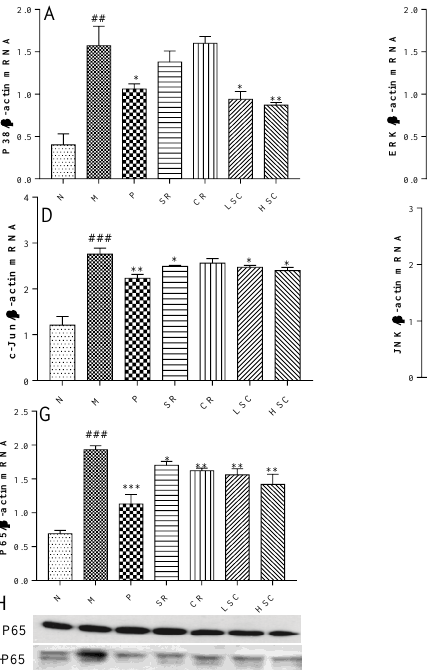
Figure 4. The effect of metformin (P), scutellaria Radix (SR), coptidis Rhizome (CR), low dose of combined extracts group (LSC) and high dose of combined extracts (HSC) on MAPK signaling pathway. ( A – G ) mRNA expression levels of c-jun N-terminal kinase (JNK), p38 mitogen-activated protein kinases (P38), extracellular regulated protein kinases (ERK), c-fos, c-jun, Inhibitor of nuclear factor kappa-B kinase (IKK) and P65 in liver of the N, M, P, SR, CR, LSC, and HSC by qPCR; ( H ) Protein levels of P65, phosphorylated P65 (p-P65) in liver of the N, M, P, SR, CR, LSC, and HSC by Western blot. The values are shown as mean ± SD. # p < 0.05, ## p < 0.01, ### p < 0.001 vs. normal group; * p < 0.05, ** p < 0.01, *** p < 0.001 vs. model group. Data were analyzed by One-way-ANOVA.